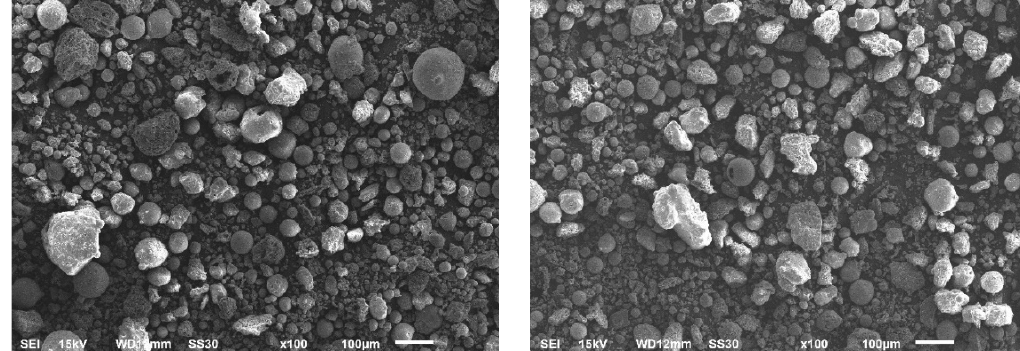
Figure 2. SEM images of the raw CFA samples from the Omsk TPS-4.